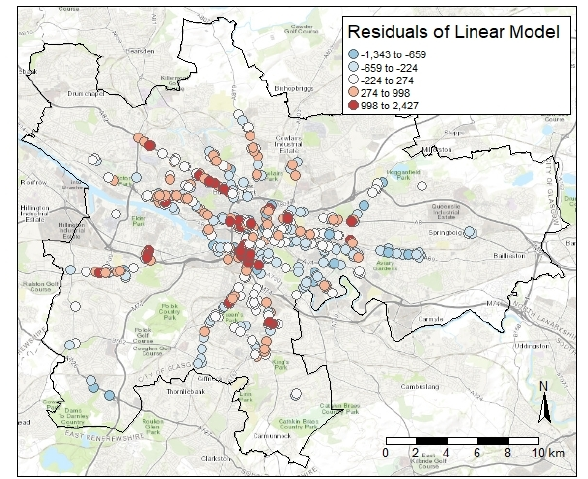
Figure 6 . Spatial distribution of residuals of the linear regression model.